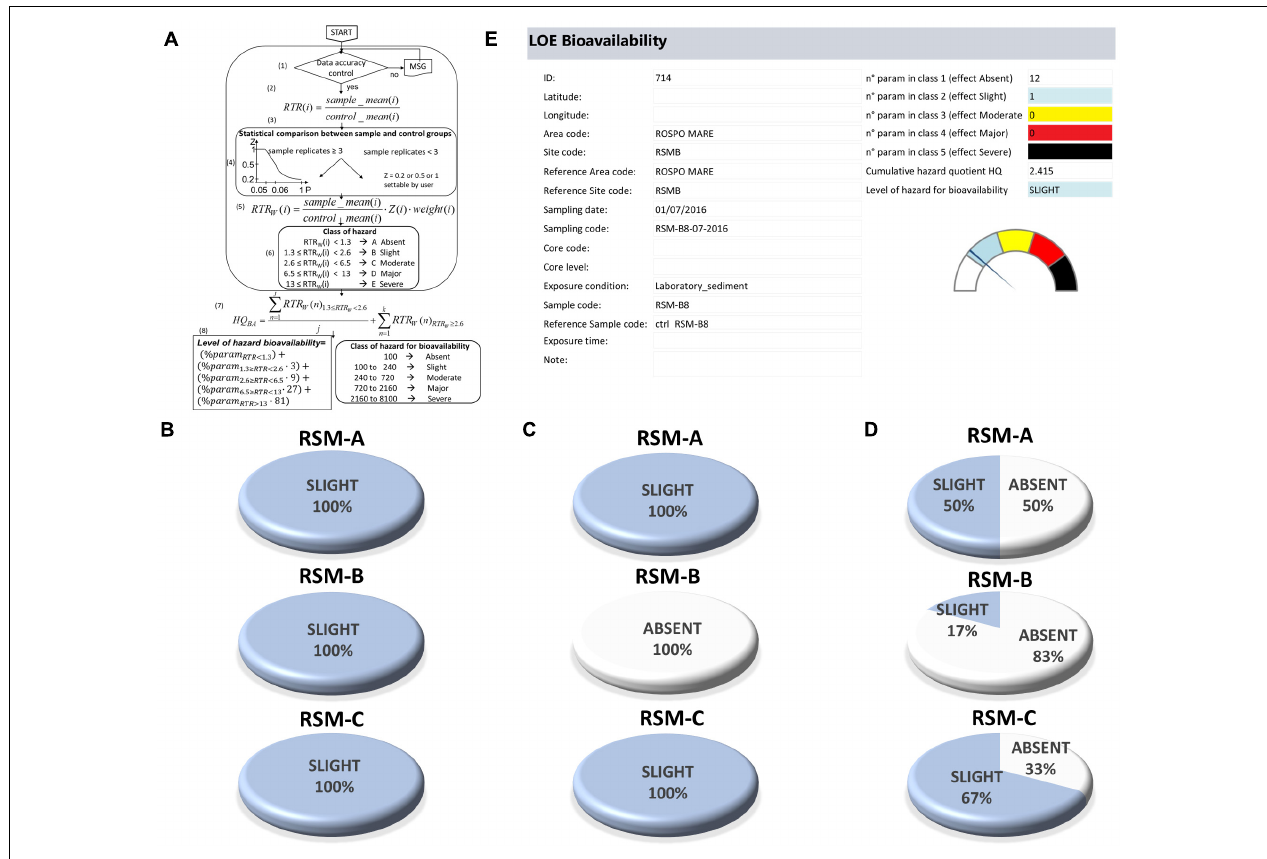
FIGURE 3 | LOE-2: elaboration of bioavailability results. (A) Flowchart and calculations of Bioavailability Hazard Quotient (HQ BA ). (B–D) Results obtained for the three platforms indicating the percentage distribution of samples assigned to various classes of hazard for native mussels (B) , transplanted mussels (C) , and laboratory exposed polychaetes (D) . (E) Model output for bioavailability characterization.